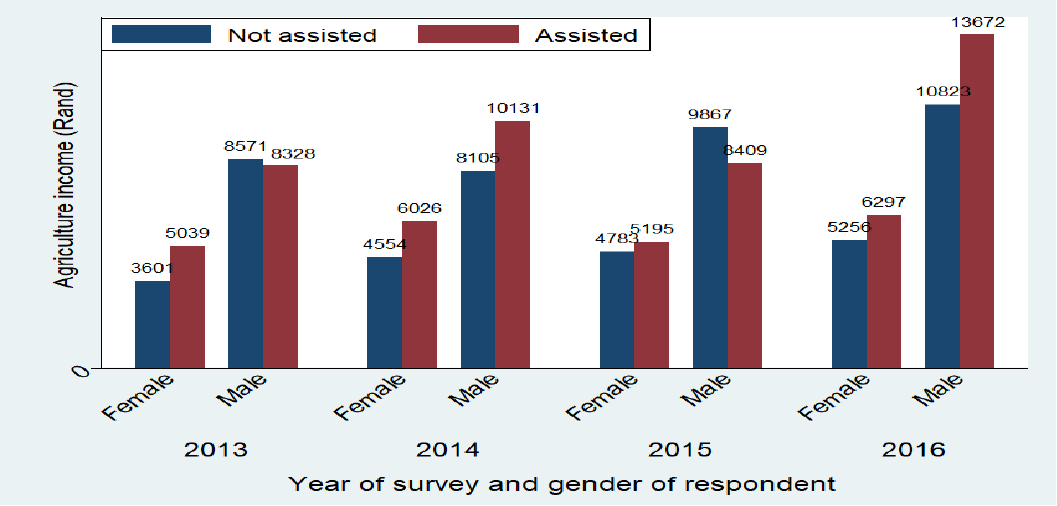
Figure 4. Average agriculture income by gender and assistance status of the respondent.